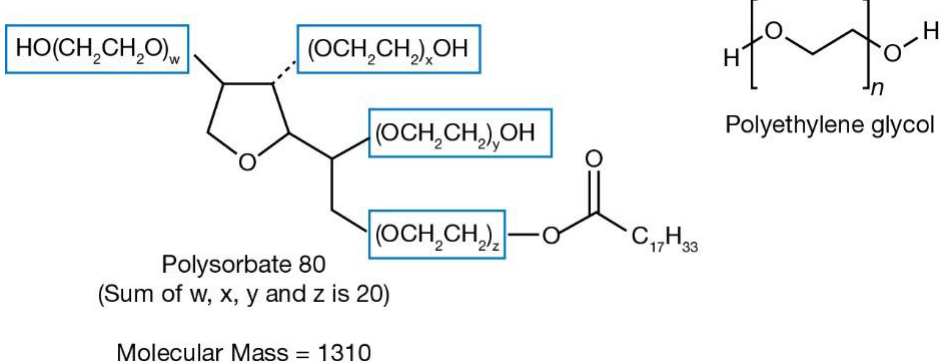
Figure 1. Chemical structures of Polysorbate 80 and polyethylene glycol (PEG). PEG has a chemical formula of H−(O−CH 2 −CH 2 ) n −OH. The PEG moieties are highlighted in blue boxes within the polysorbate 80 molecule.